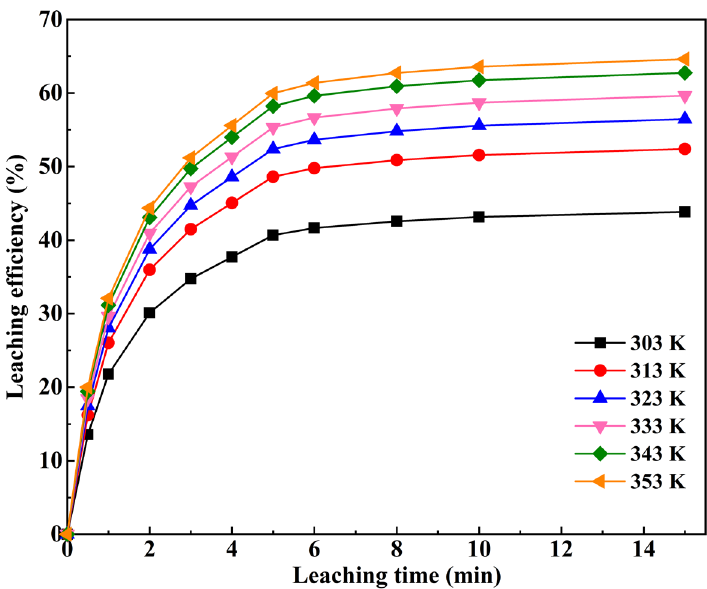
Figure 12. Effect of leaching time on the Si leaching efficiency at various leaching temperatures.